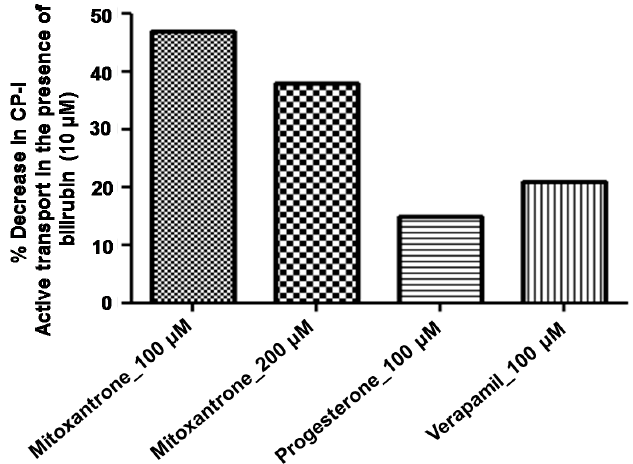
Figure 3. Effect of bilirubin on the transport of CP-I using rat Mrp2 vesicles in the presence and absence of modulators. Rat Mrp2 vesicles (50 µg/well) were preincubated with and without bilirubin (10 µM) and modulators for 3 min at 37 °C. % Net decrease in ATP-dependent CP-I uptake in presence of bilirubin was calculated by taking CP-I uptake values in presence of modulators as control. All data values presented as mean of single experiment performed in duplicate wells. The duplicate values are: 54%, and 40% (mitoxantrone 100 µM), 34% and 42% (mitoxantrone 200 µM), 17% and 12% (progesterone 100 µM), and 21, and 21% (verapamil 100 µM).